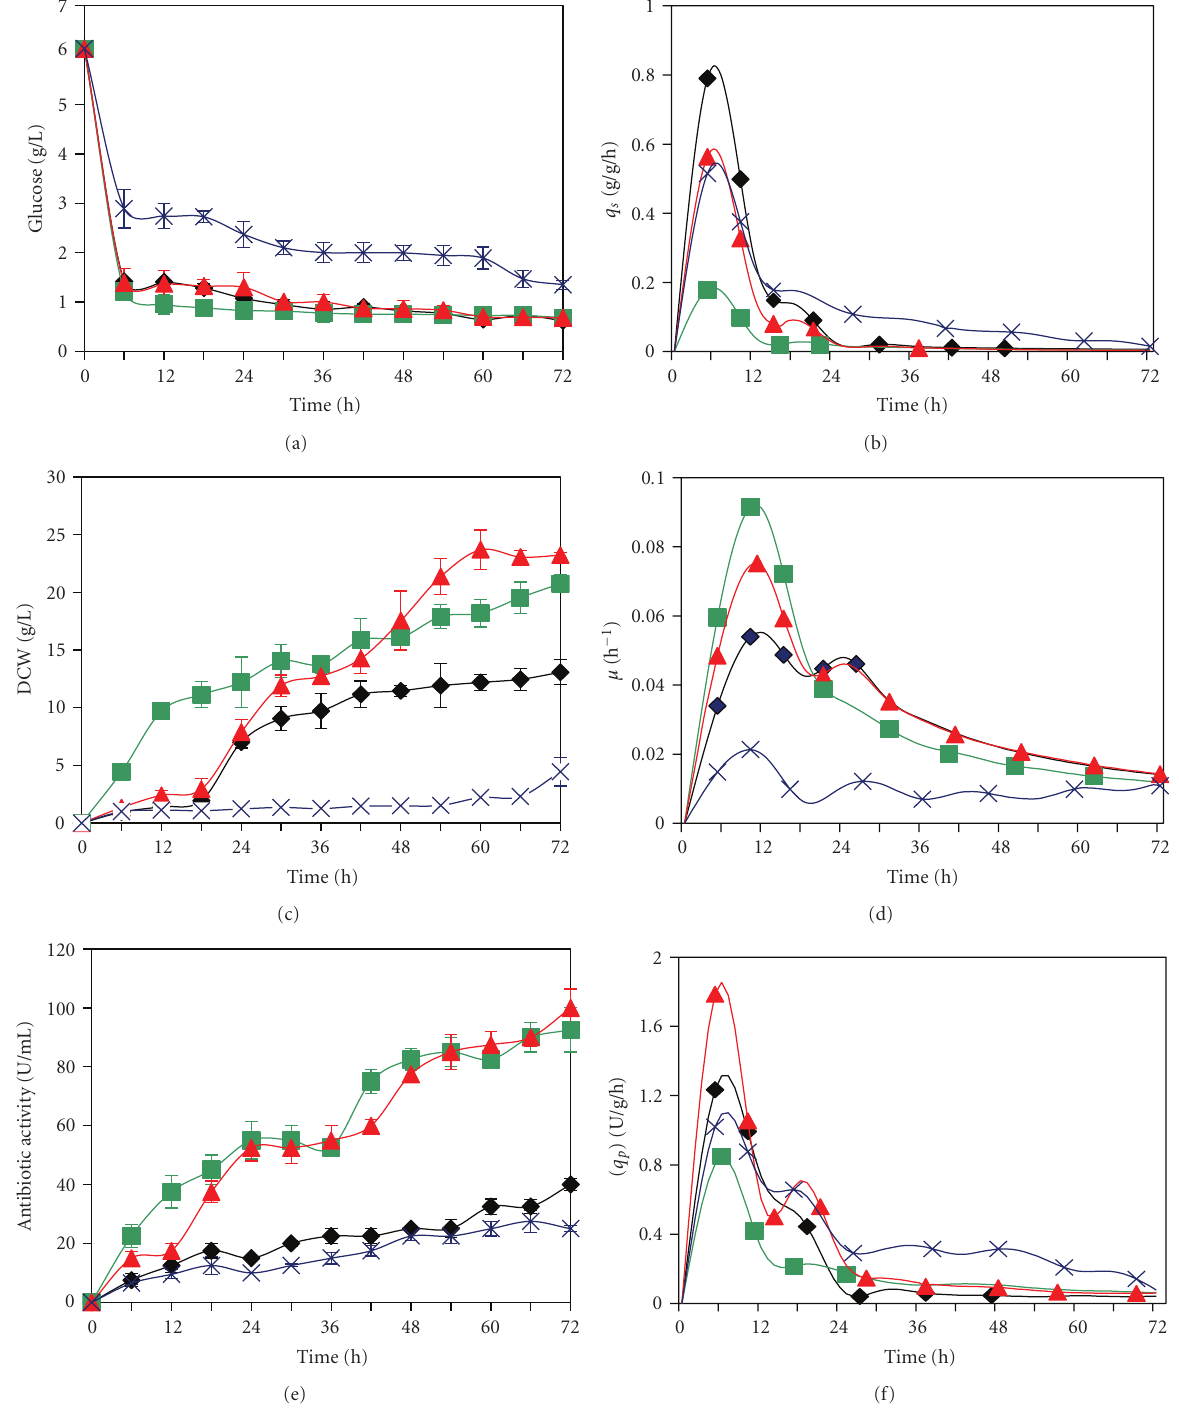
Figure 3: Time profiles of glucose (a), q s specific glucose consumption rates (b), cell growth (c), μ -specific cell growth rate (d), antibiotic activity (e), q p -specific antibiotic production rate (f) in the cultivation of X. nematophila YL001 at di ff erent pH pH 4.5 ( ); and pH 9.5 ( × 7.5 ( (cid:3)